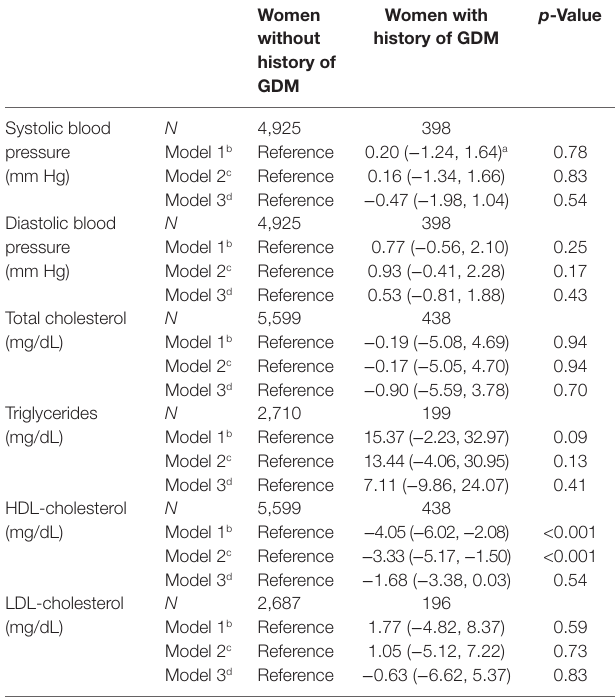
TaBle 3 | Association between history of GDM and CVD risk factors among parous women. p